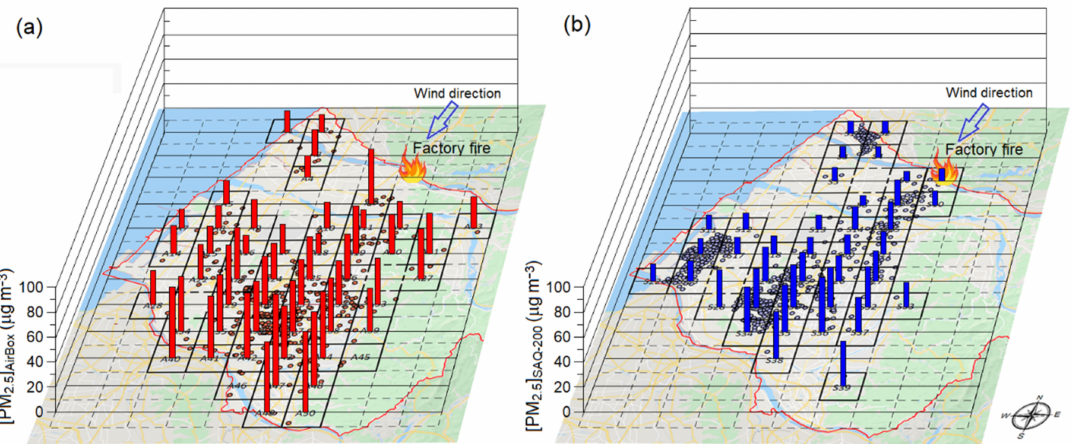
Figure 14. Spatial anomaly analysis of a fire accident using the PM 2.5 average concentrations of clusters in Taichung. Observations from ( a ) the AirBox sensor system and ( b ) the SAQ-200 sensor system at 10:00 on 8 May